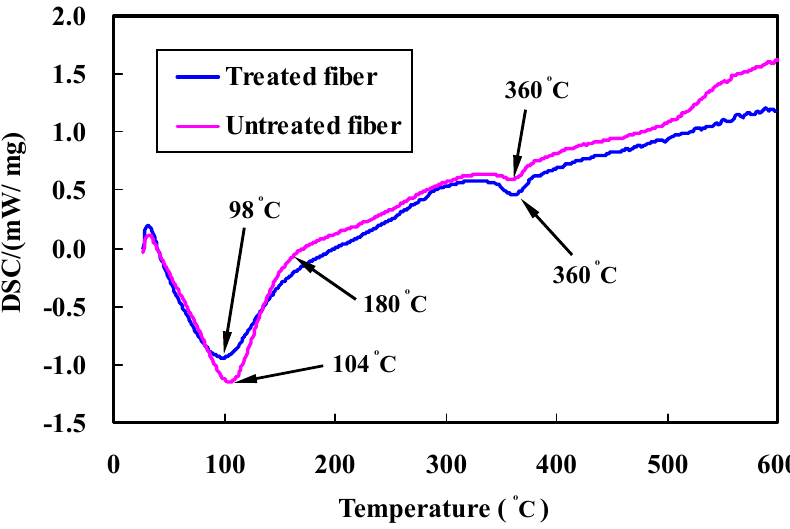
Figure 6. DSC analysis of untreated and alkali treated bamboo fibers.